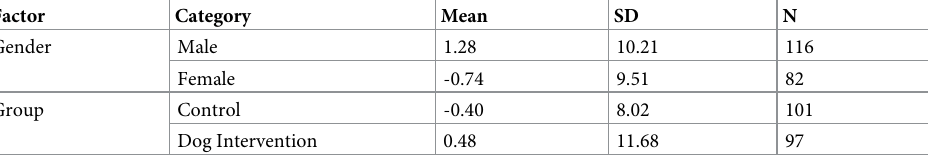
Table 18. Descriptive statistics for heart rate. Factor Category